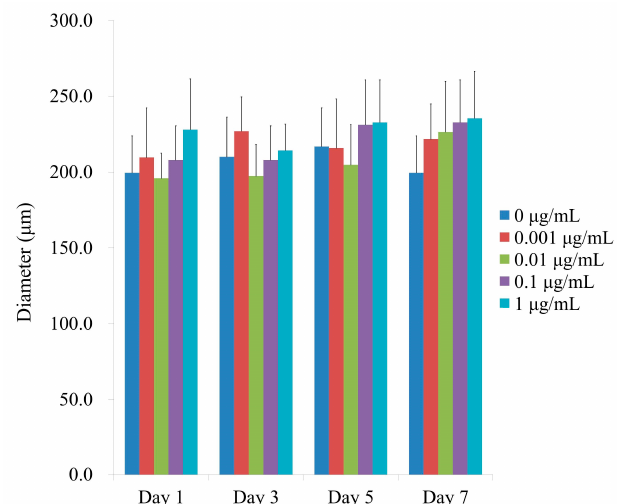
Figure 2. The morphology of the cell spheroids on Days 1, 3, 5, and 7 after exposure to various CMT concentrations in osteogenic medium was assessed using inverted microscopy (original magnification ×200 ). The bar shows 200 μm.